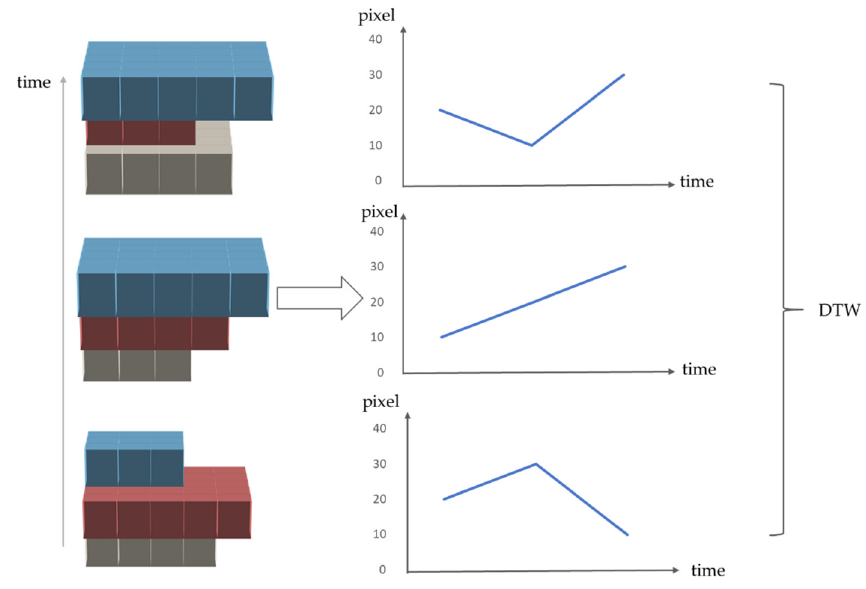
Figure 6. Schematic diagram of DTW calculation method for short-term IST-cube.